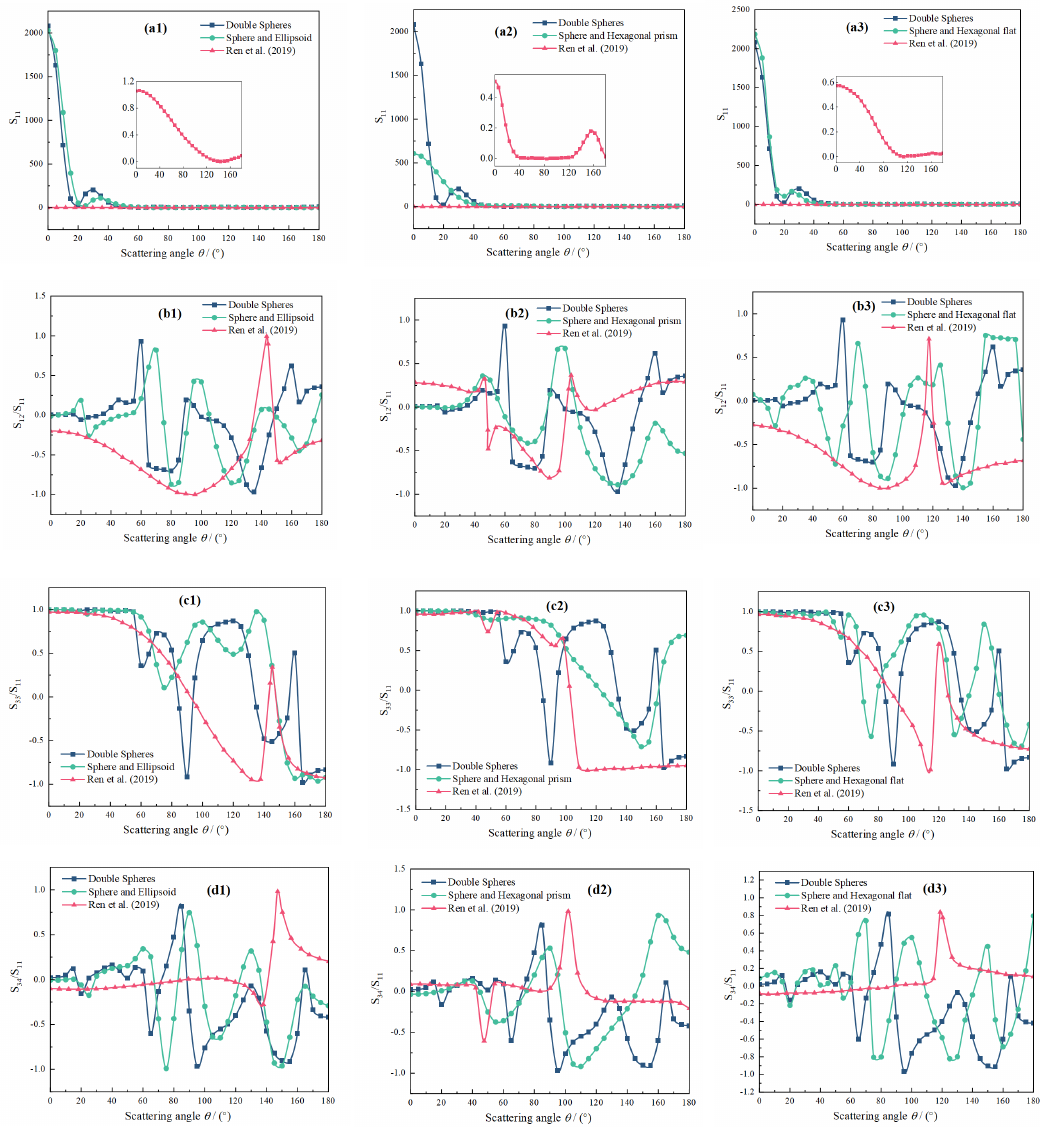
Figure 5. Influence of shapes of ice crystals with aggregated structures on Mueller matrix elements